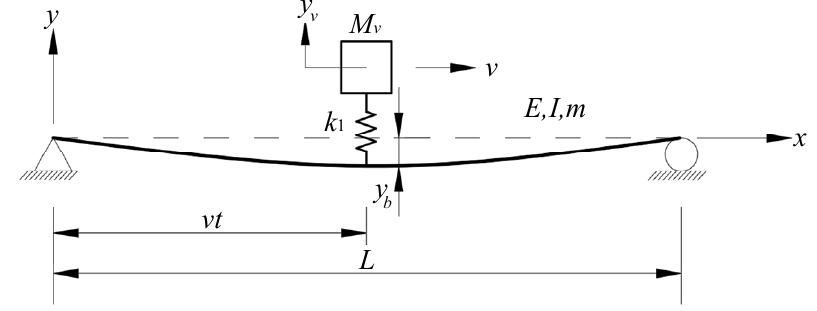
Figure 2. Model of a moving sprung mass through a simply supported beam bridge.